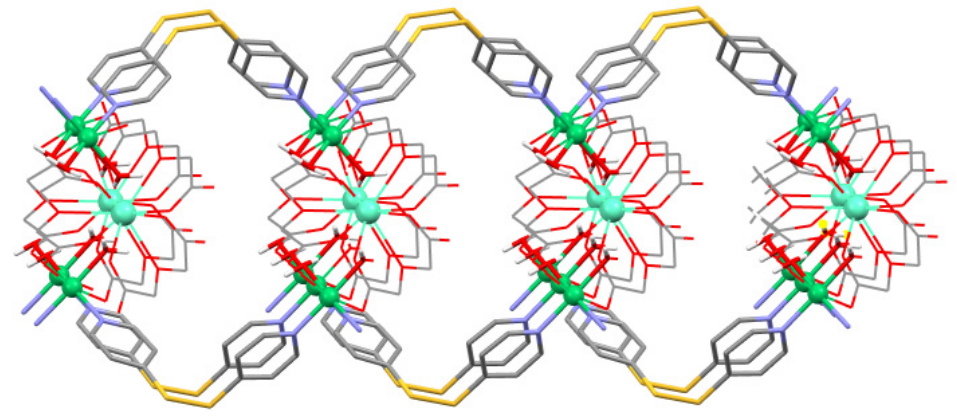
Figure 34. Section of the two-dimensional coordination network in [Eu( μ ( μ -C H O ) {Ni( μ - dtdp )} 4 4 5 2 [010]